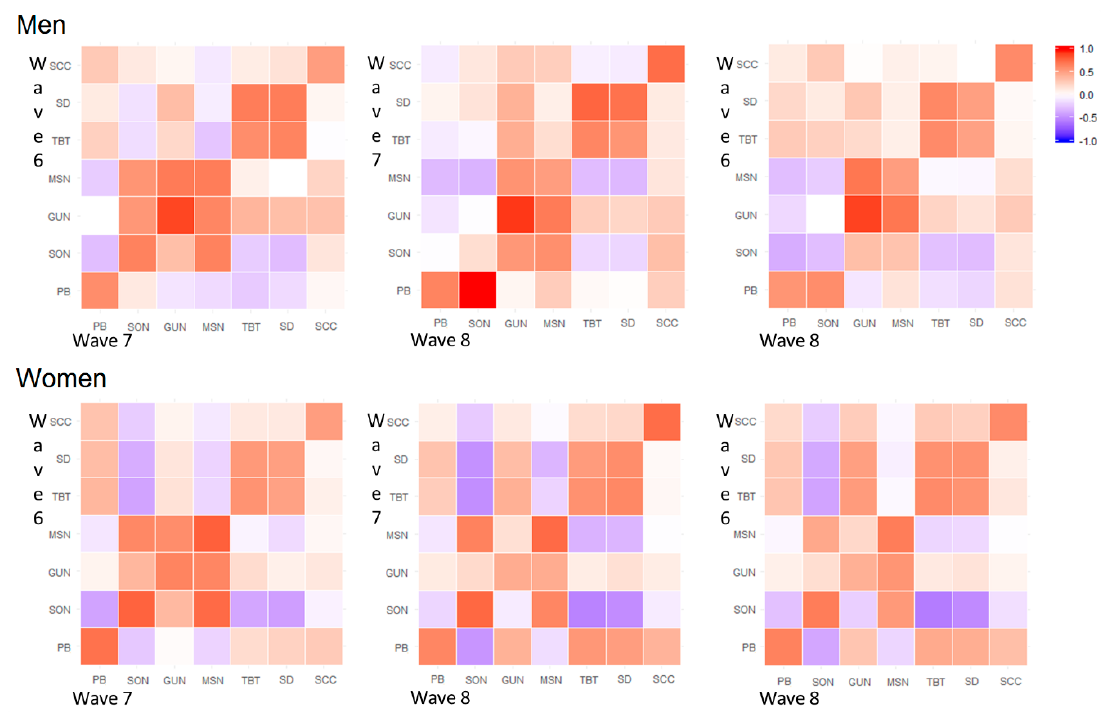
Figure 2. Heat maps of Pearson correlation coefficients of sleeping features, child sleep quality scores, and relationship satisfaction scores for different time points during working days. Note: SCC: Child sleeping quality score, PB: Partner relationship score, SD: Sleep duration, TBT: Time spent in bed, MSN: Middle sleep, GUN: Time getting out of bed, SON: Sleep onset.